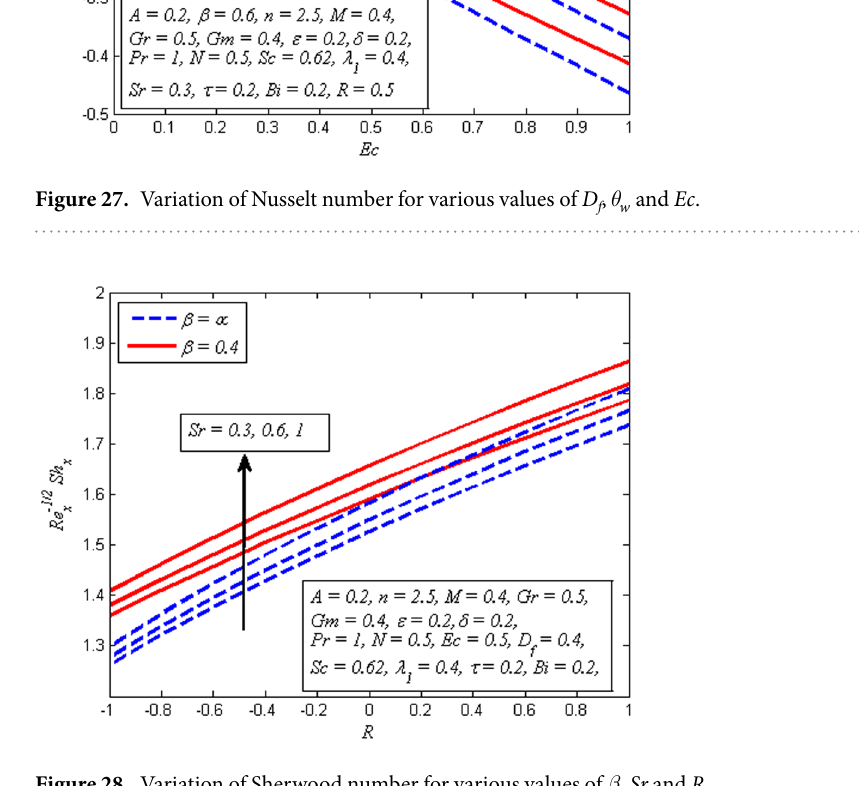
Figure 28. Variation of Sherwood number for various values of β , Sr and R .